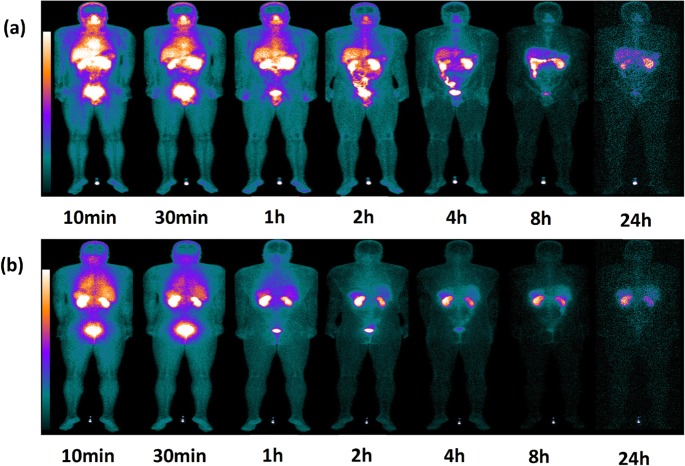
Series of planar whole-body images of a representative subject showing the distribution of 99mTc-RGD-BBN between 10 min and 24 h post-injection.(a) Anterior planar whole-body images. (b) Posterior planar whole-body images.